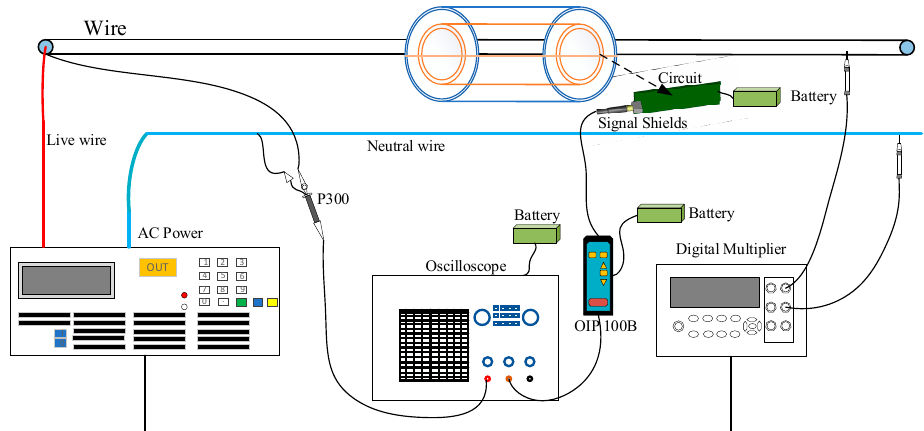
Figure 12. Experimental schematic.